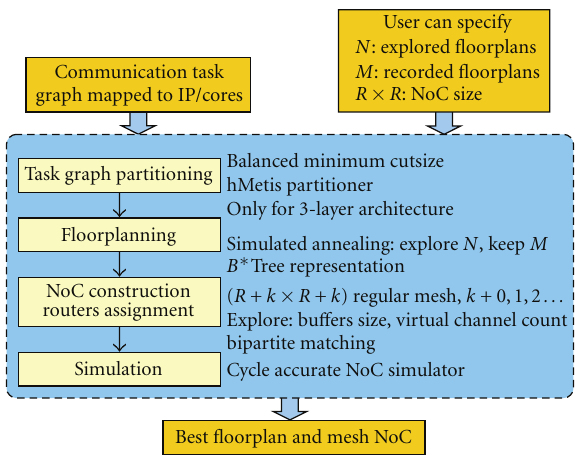
Figure 3: Proposed NoC design exploration methodology.